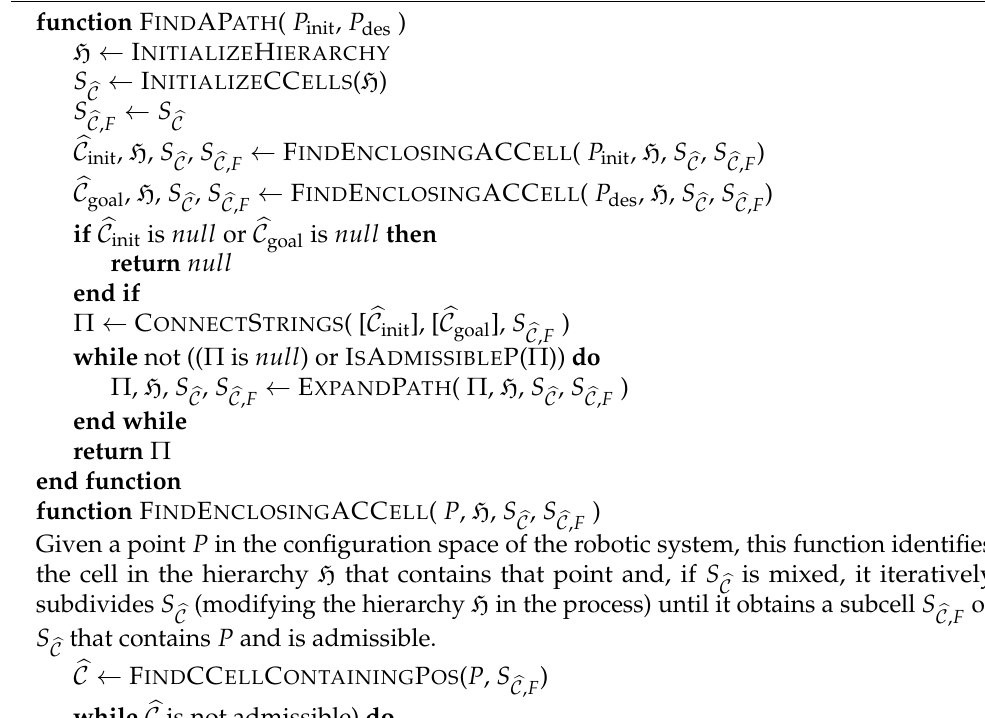
Algorithm 1 Planner’s Main